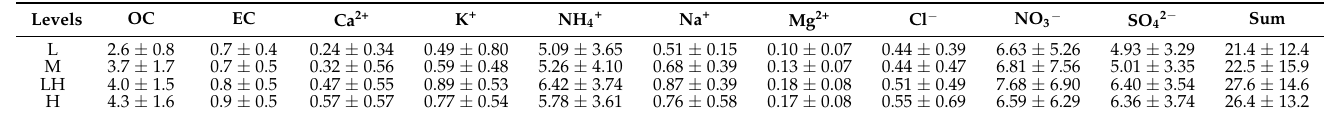
Table 1. The chemical component concentrations in PM 2 . 5 under the different photochemical activ- ity levels (mean ± SD, μ g/m 3 ).